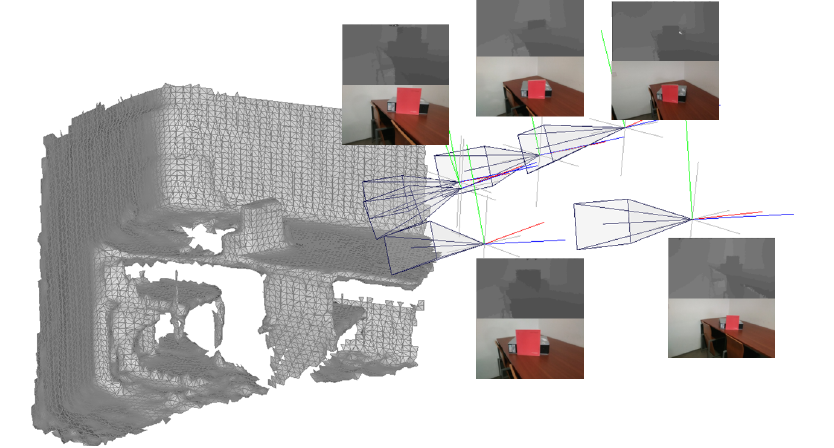
Figure 1. Inputs for 3D texture mapping.